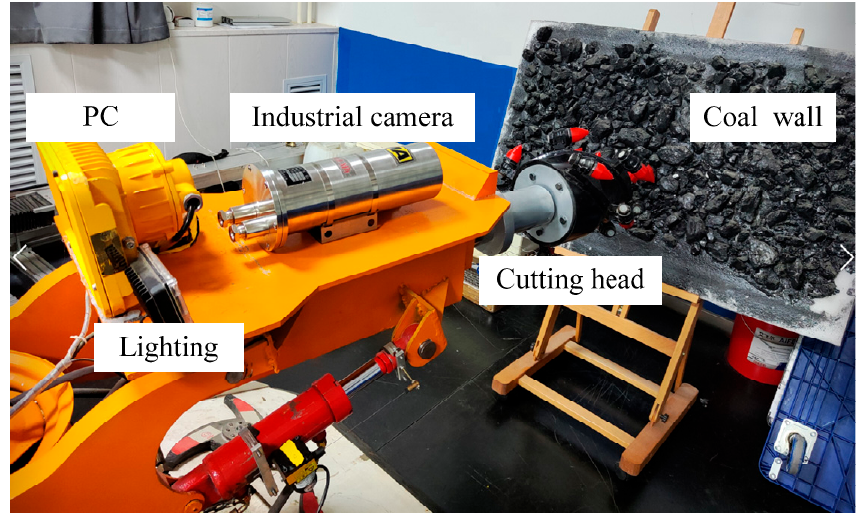
Figure 10. Laboratory simulation operation.